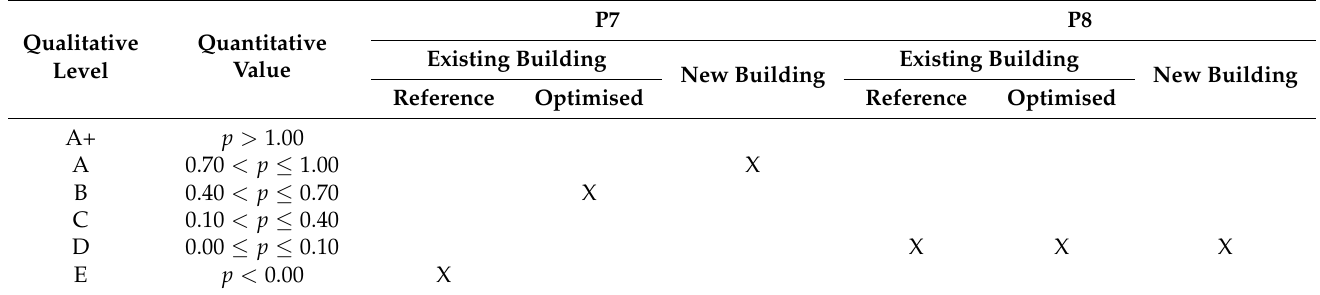
Table 8. Final score for parameters P7 and